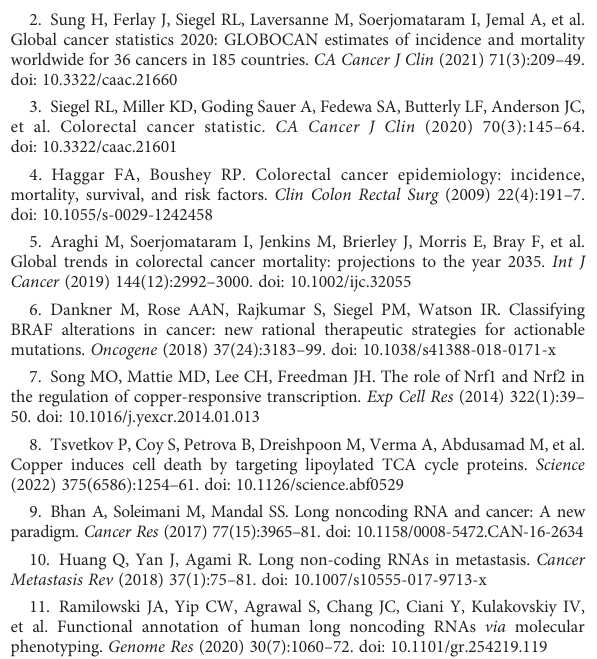
SUPPLEMENTARY FIGURE 1 Work fl ow of the construction and validation of this prognostic signature. SUPPLEMENTARY FIGURE 2 Associations between cuproptosis-related lncRNAs expression and survival. (A-J) The Kaplan-Meier curves showed overall survival of patients with high(red) or low(blue) cuproptosis-related lncRNAs expression in the training set. p< 0.05 in the two-sided log-rank test was considered statistically signi fi cant. SUPPLEMENTARY FIGURE 3 Comparison with the previously published lncRNAs signature. (A) Kaplan- Meier curve analyses showed high-risk group was correlated with poor prognosis in COAD according to the previous study. (B) The accuracy of the previously published model (B) and our signature (C) was veri fi ed using ROC analysis in TCGA